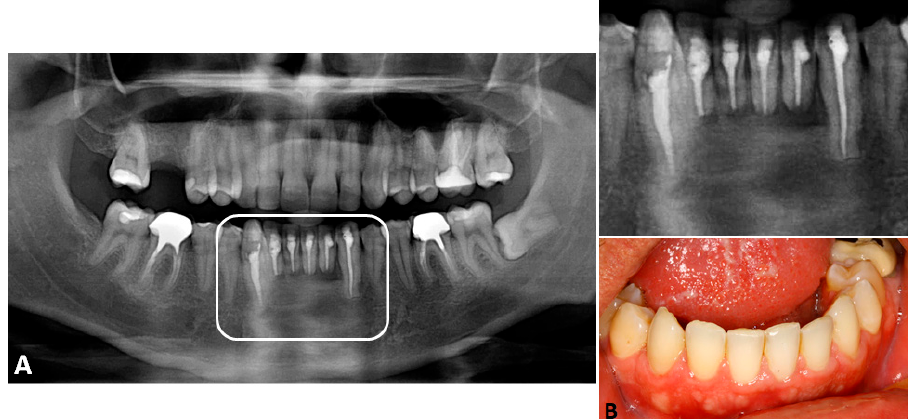
Figure 5. Follow-up of fifteen months after the second procedure. ( A )—The panoramic radiograph showed bone neoformation within the entire surgical site, with no signs of recurrence. ( B )—Clinically, the mucosa was found to be healthy, and the involved teeth were in function, without functional or aesthetic